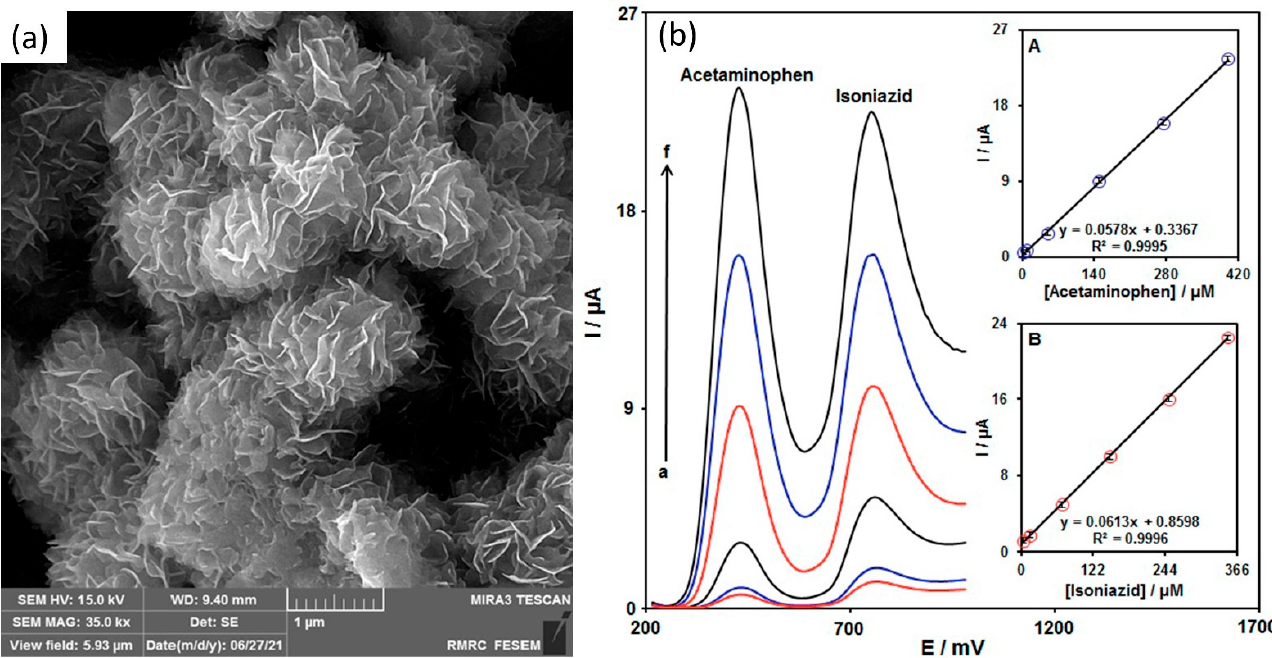
Figure 5. ( a ) FESEM image of MoS 2 nanosheets synthesized in Tajik et al.’s laboratory. ( b ) Differential pulse voltammetry of simultaneous detection of INZ and AC on MoS 2 -NSs/SPE. Inset ( A ): The anodic peak current plot vs. AC concentration. Inset ( B ): The anodic peak current plot vs. INZ concentration. Reprinted with permission from [114]. Copyright 2022 MDPI. Authors licensed